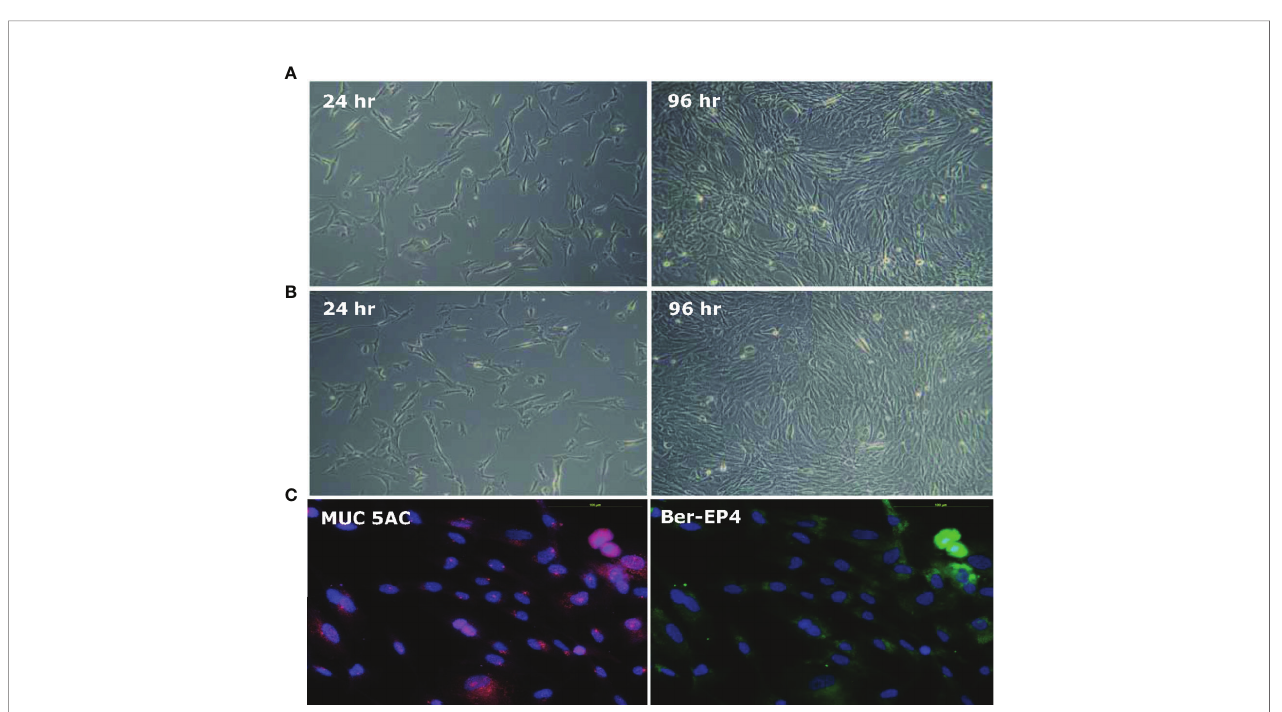
FIGURE 1 | Establishment of human stomach fetal epithelium (HSFE) cells from human fetal stomach cells (HFSC). Human fetal stomach cells (HFSC) were cultured in (A) D ‐ PRO ‐ 015 and (B) modi fi ed 2/3 E-Pro and 1/3 DMEM Medium with 5% CO2 at 37°C for 24 and 96 hours under a 10X phase contrast microscope. The D ‐ PRO medium was changed every second day, and the cells were subcultured before they overgrew until they were induced to HSFE cells. (C) Most of the cells were positive for anti-MUC5AC (pink) monoclonal antibodies, a marker of gastric epithelial cells, with Ber-EP4 (blue) nuclear staining and negative for vimentin (not